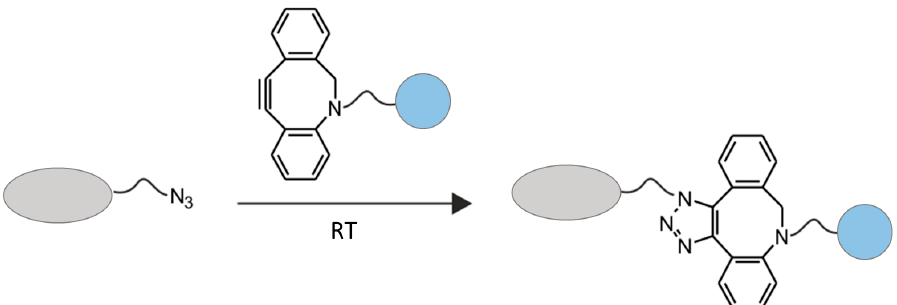
Figure 2. A reaction scheme of strain-promoted azide-alkyne cycloaddition. The azide was reacted with the dibenzylcyclooctyne (DBCO) in a Cu(I)-free [2 + 3] cycloaddition under mild conditions to produce 1,4-substituted triazoles.